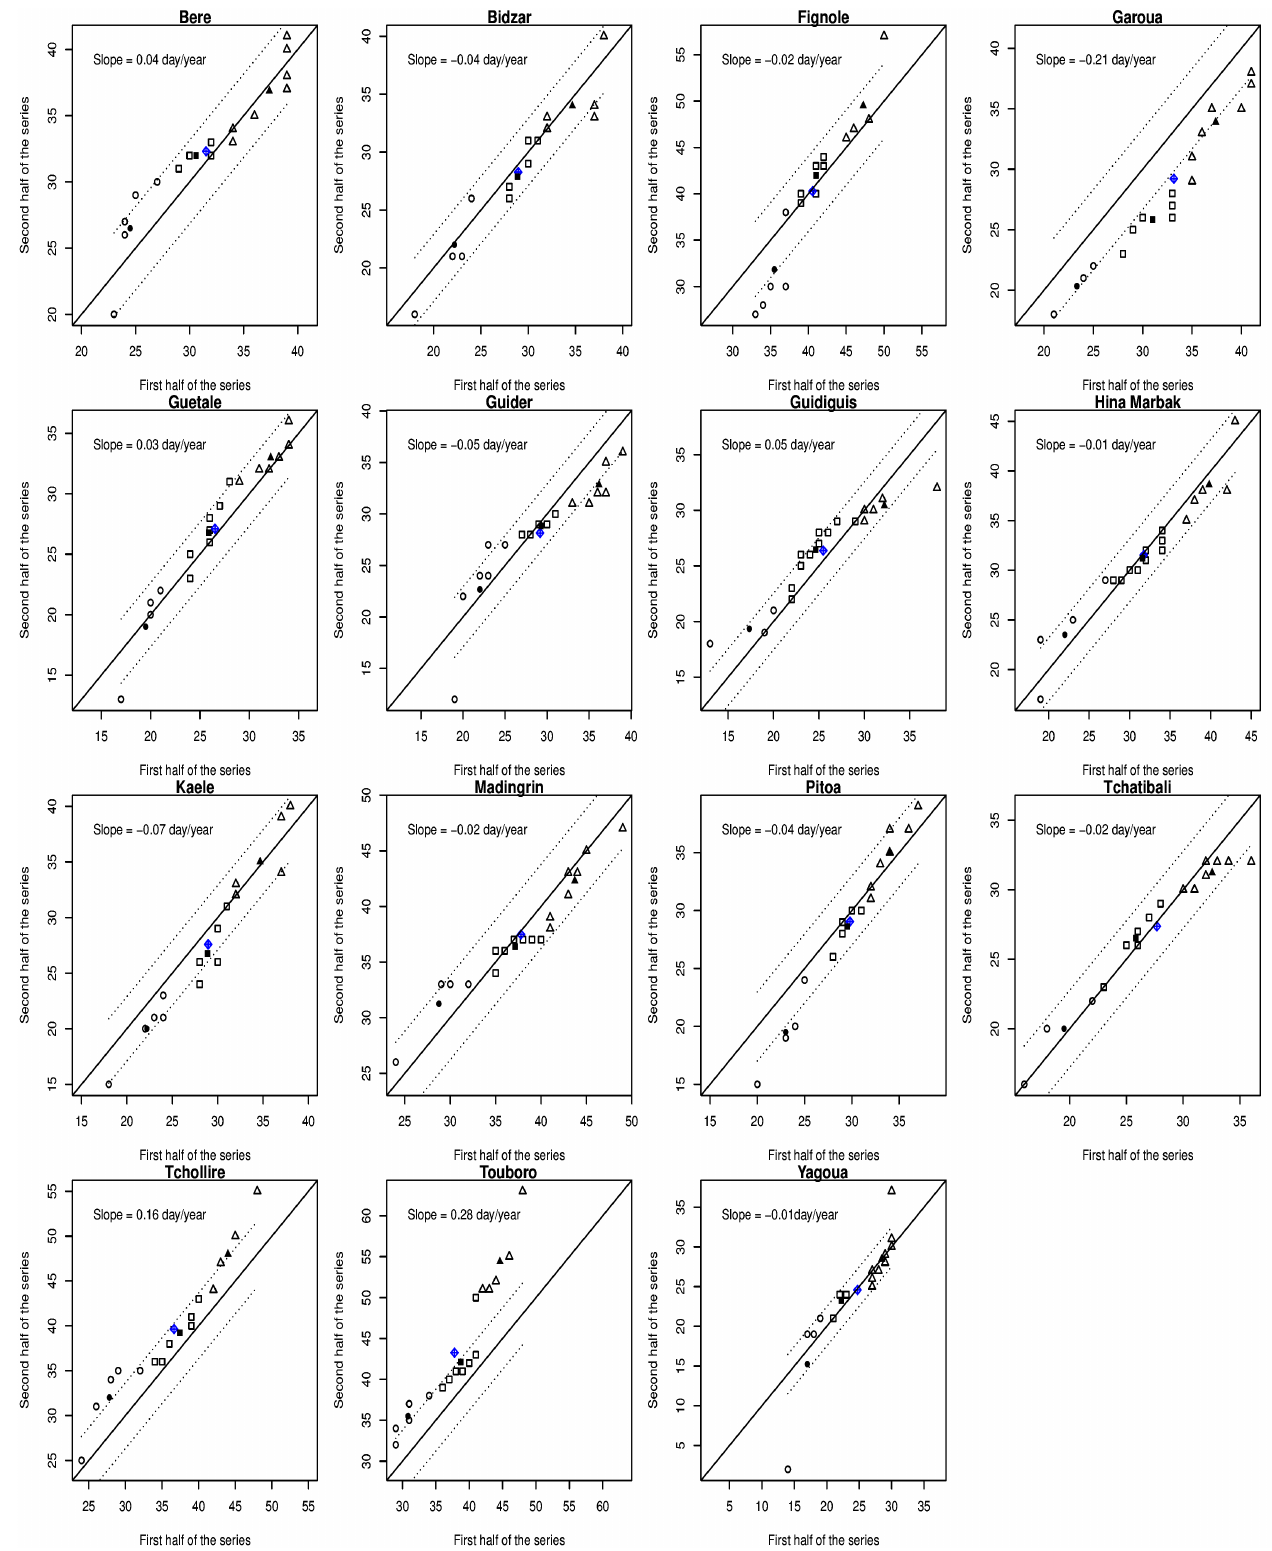
Figure 10. As in Figure 9, but for R10mm.